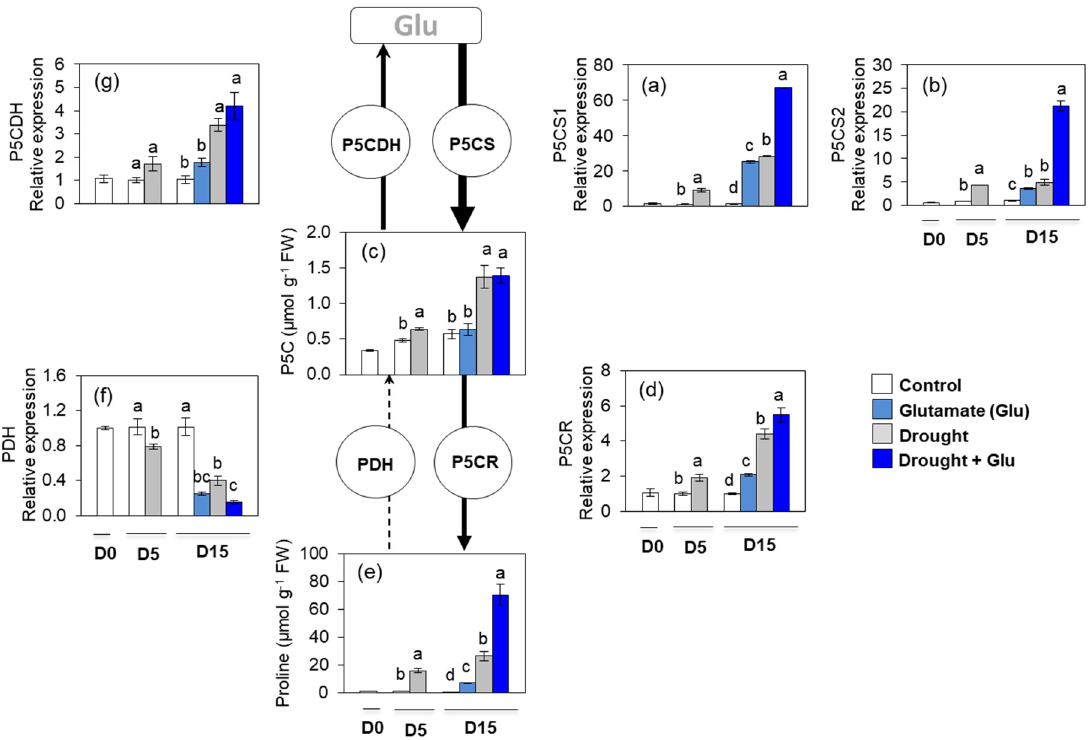
Figure 5. Changes in proline metabolism as affected by glutamate (Glu) application in the leaves of Brassica napus under well-watered or drought-stressed conditions. ( a ) Pyrroline-5-carboxylate (P5C) synthase 1 ( P5CS1 ), ( b ) P5CS2 , ( c ) P5CS content, ( d ) pyrroline-5-carboxylate reductase ( P5CR ), ( e )